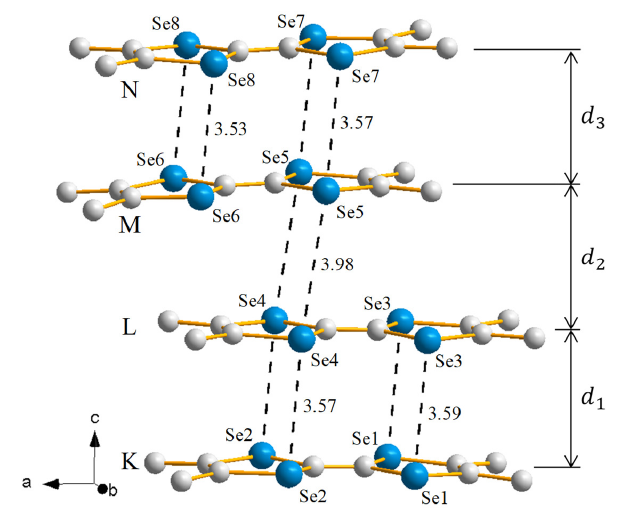
Figure 9. Donor arrangement in a tetramer of (TMTSF) 4 (I 3 ) 4 · THF. Hydrogen atoms are not shown for clarity. The crystallographically independent TMTSF molecules are labeled K, L, M and N, respectively. The broken lines show the Se · · · Se contacts shorter than 4.0 Å. The interplanar distances are d 1 = 3.599 ( 5 ) Å (K–L), d 2 = 3.92 ( 7 ) Å (L–M), and d 3 = 3.53 ( 2 ) Å (M–N),